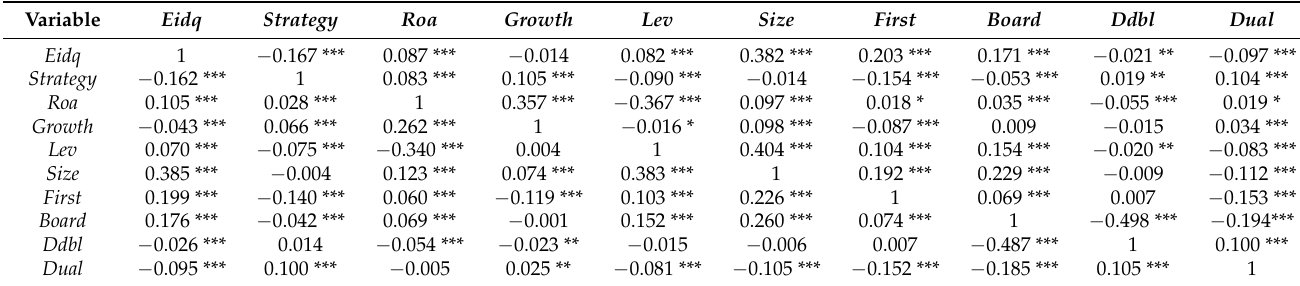
Table 5. Correlation matrix (Pearson bottom and Spearman